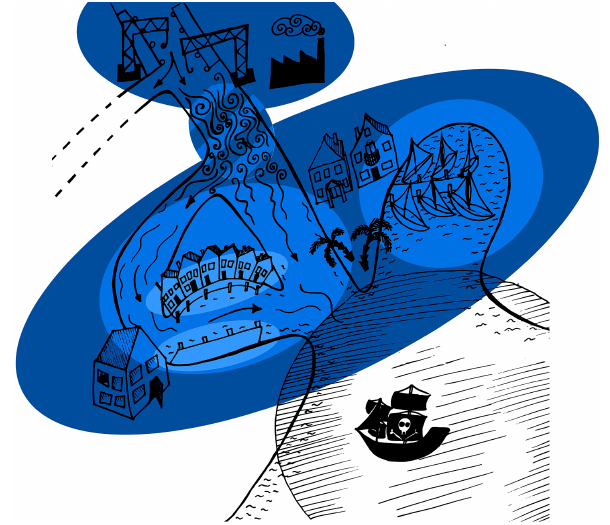
Figure 3. Illustration of port, harbour, and dock dilemmas intro- duced in Sect. 1.1 (“Metaphorical framework”). As in Fig. 1, hu- manity can float in and row a boat on a complex waterway. From the upper port city (upper dark-blue region), one can get to some unknown region to the left and to another, nicer port city (lower dark blue) at the shore through a rapid (hatched blue) which cannot be traversed in the other direction. This choice between desirabil- ity and flexibility forms a port dilemma . The nicer port city has two harbours (middle blue regions), of which the right one is more desirable, and between which one can switch only through an unde- sired region where pirates loom (circular area). Boats in the left har- bour face the harbour dilemma of choosing between either avoiding the undesired region by all means or eventually reaching a place of higher desirability. Finally, in the left harbour there are two safe docks (light-blue regions), of which the top one is more desirable, and between which one can switch only through an unsafe part of the harbour from which one may be drawn into the undesired region if the engine fails. Boats in the bottom dock face the dock dilemma of choosing between uninterrupted safety and eventual higher de-